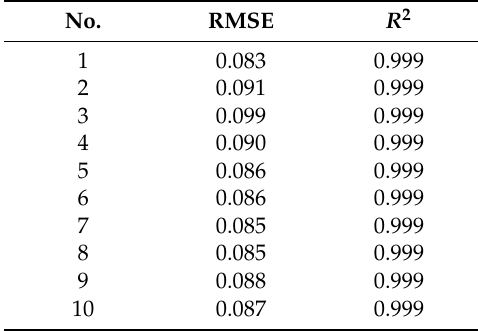
Table 4. Test results of running the LSTM model 10 times on the test dataset.